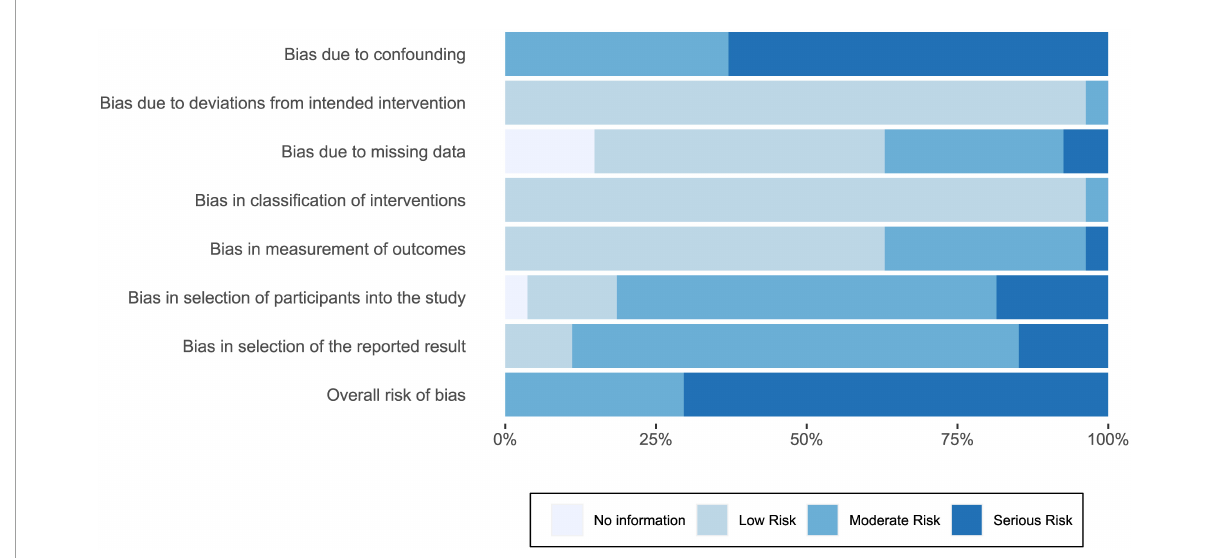
FIGURE3 Summary of risk of bias judgments, illustrating the proportion of studies that were judged to be at low, moderate, or serious risk of bias (or whether sufficient information was not available for a judgment) for individual domains of bias and overall risk.